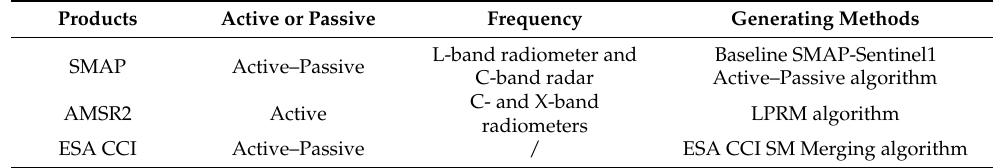
Table 1. Information about products.